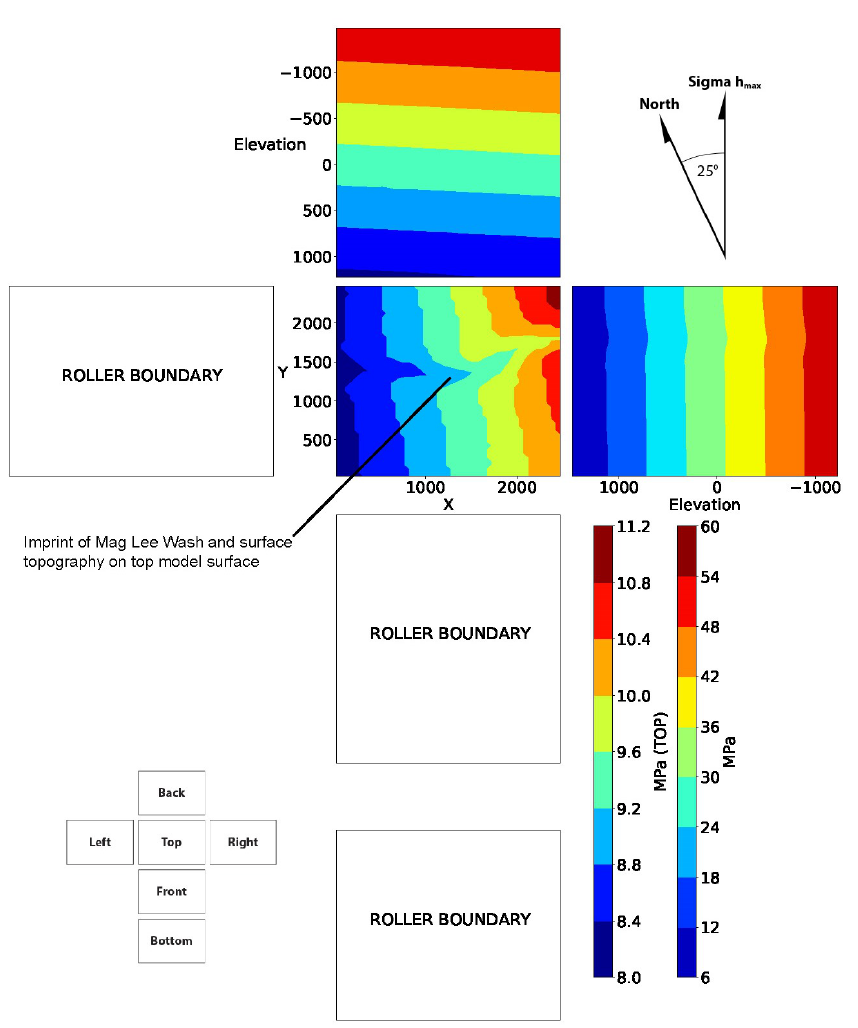
Figure 11. Stress boundary conditions as the total stress. Note the influence of the site topography imprinted on the top surface of the model